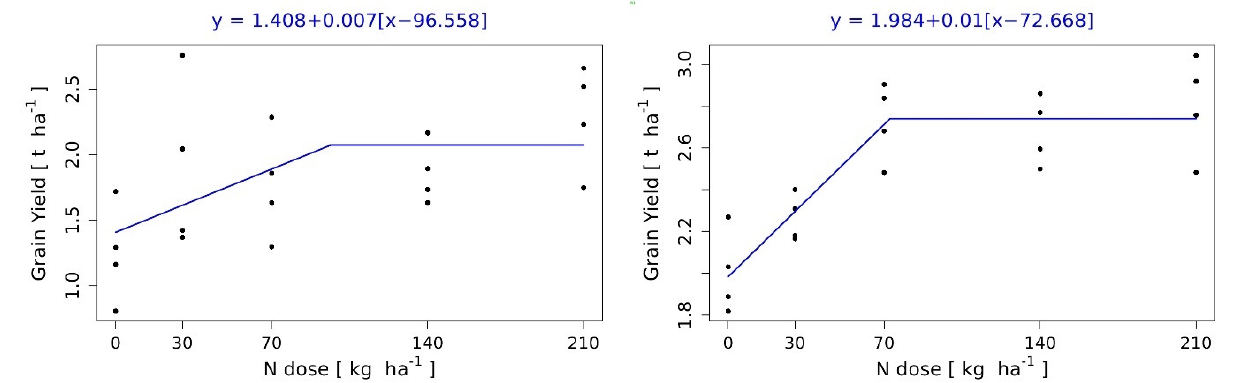
Figure 7. The response of FP yields to different doses of mineral N fertilizers (NPK, NPK E1, NPK E2, NPK E3 treatments) in 2017 ( left ) and 2020 ( right ). Yields (black dots) are interleaved with the linear-plateau model (blue line). The equation of the model is given above the figure.